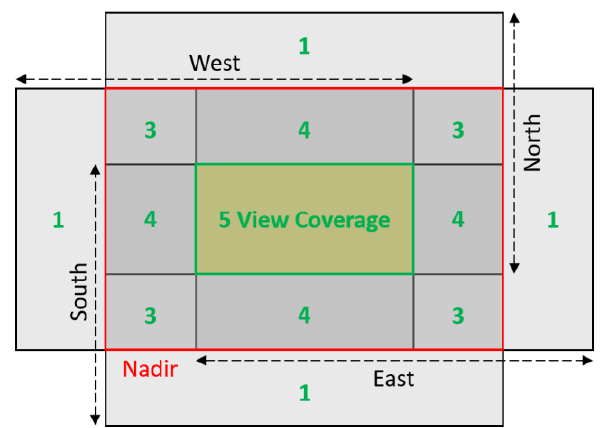
Figure 2. Illustration of an oblique sensor’s block layout, with a central (usually large) five-view coverage and partial coverage near the block edges. If flown in East-West direction, left/right or backward/forward sensors images are looking North/South or East/West,